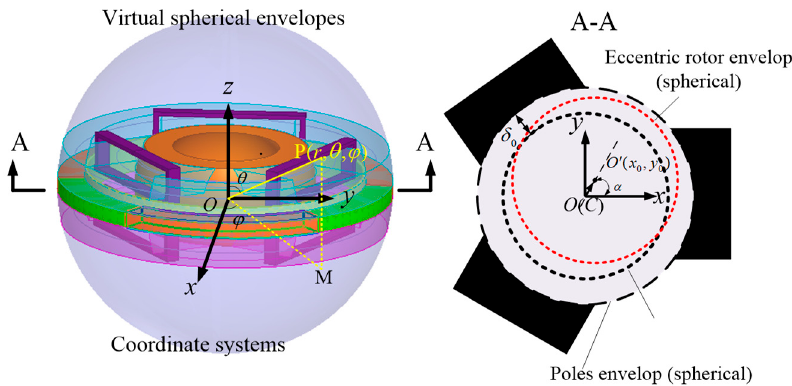
Figure 2. Coordinate system and rotor eccentricity diagram.